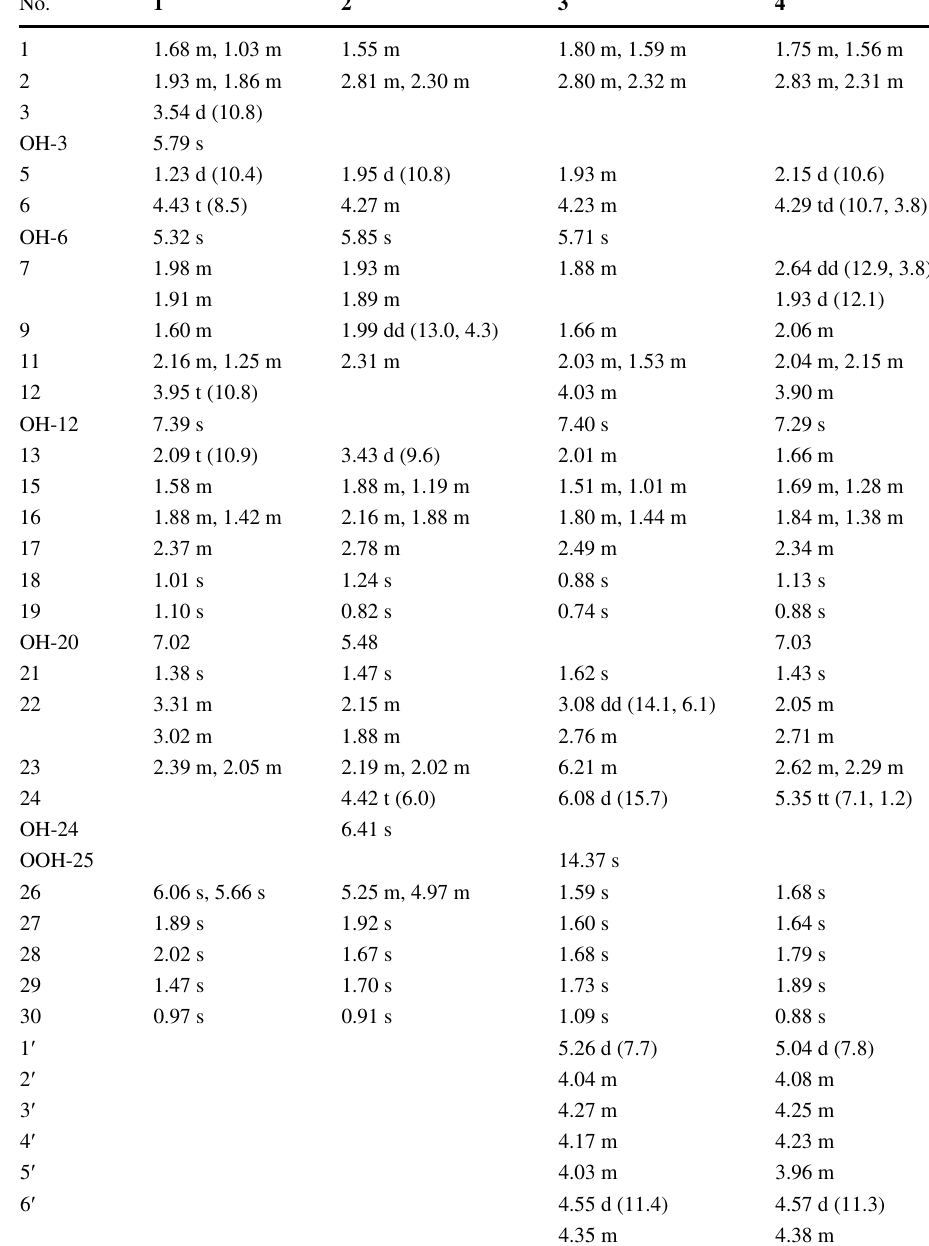
Table 2 1 H (600 MHz)